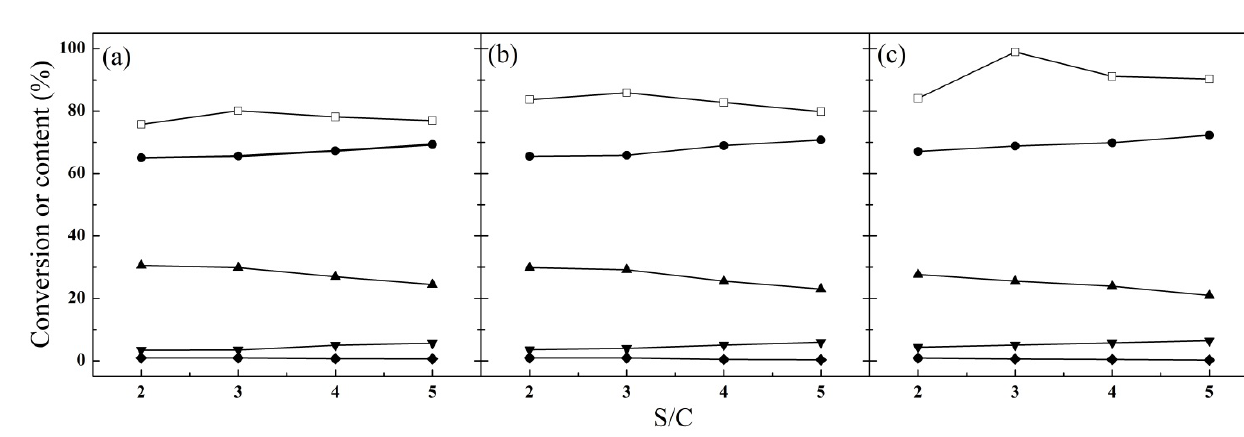
Figure 6. Effects of S/C rations on the toluene conversion and the gas composition. ( a ) Ni/SBA-15; ( b ) Ni-CeO ( □ ) toluene conversion; ( ● ) H